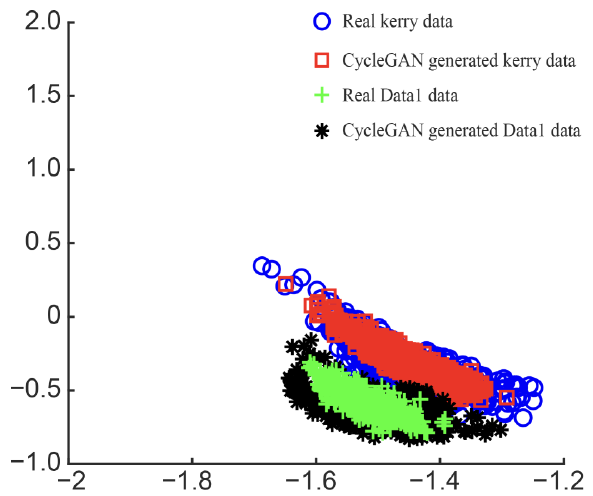
Figure 6. Relative texture dissimilarity of different data sets.